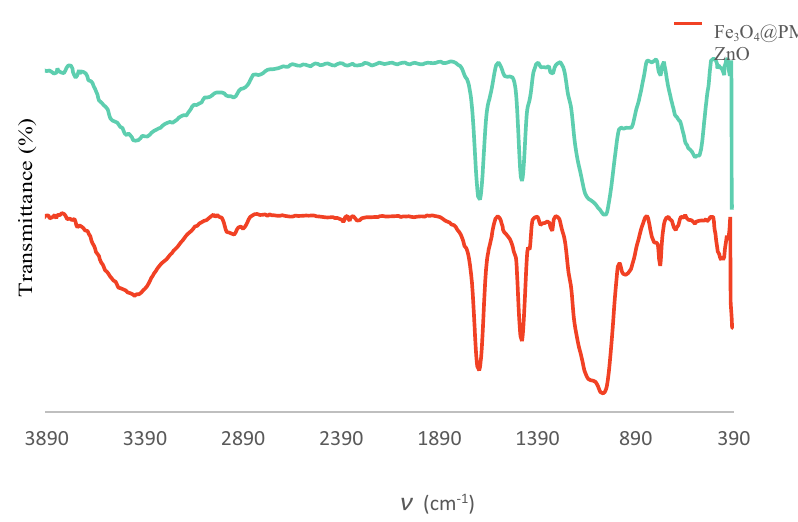
Figure 3. FTIR spectra of the PMO-ICS and magnetic Fe 3 O 4 @PMO-ICS-ZnO nanoporous catalyst ( 1 ).